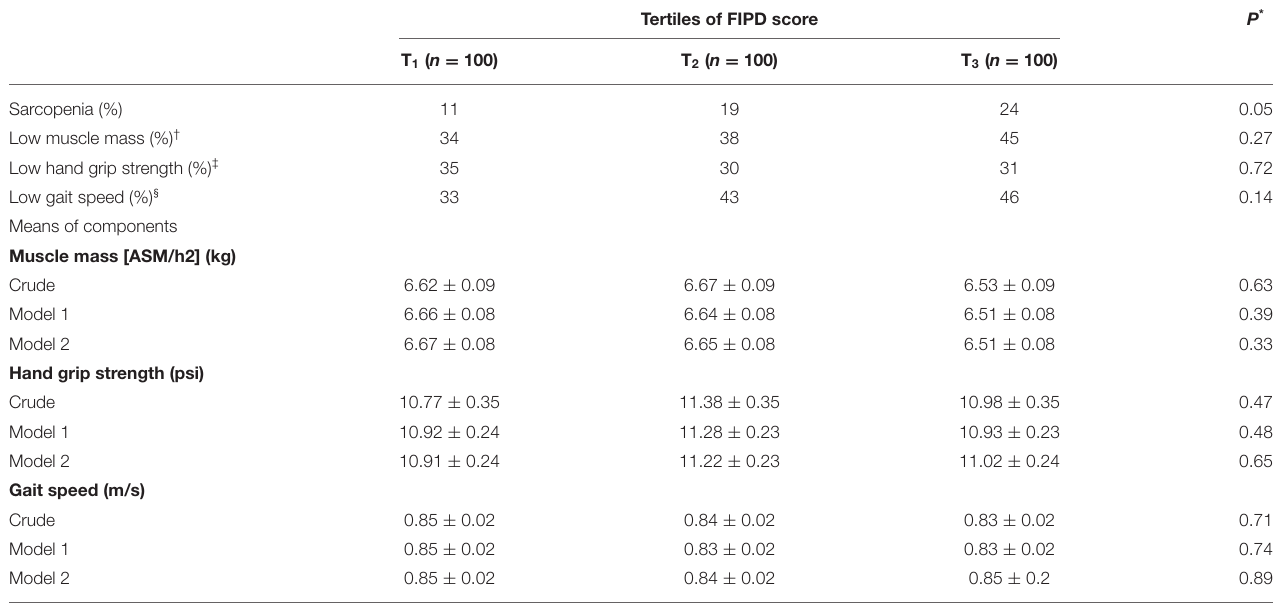
TABLE 3 | Distribution of sarcopenia and its components across tertile FIPD categories. Tertiles of FIPD score P *